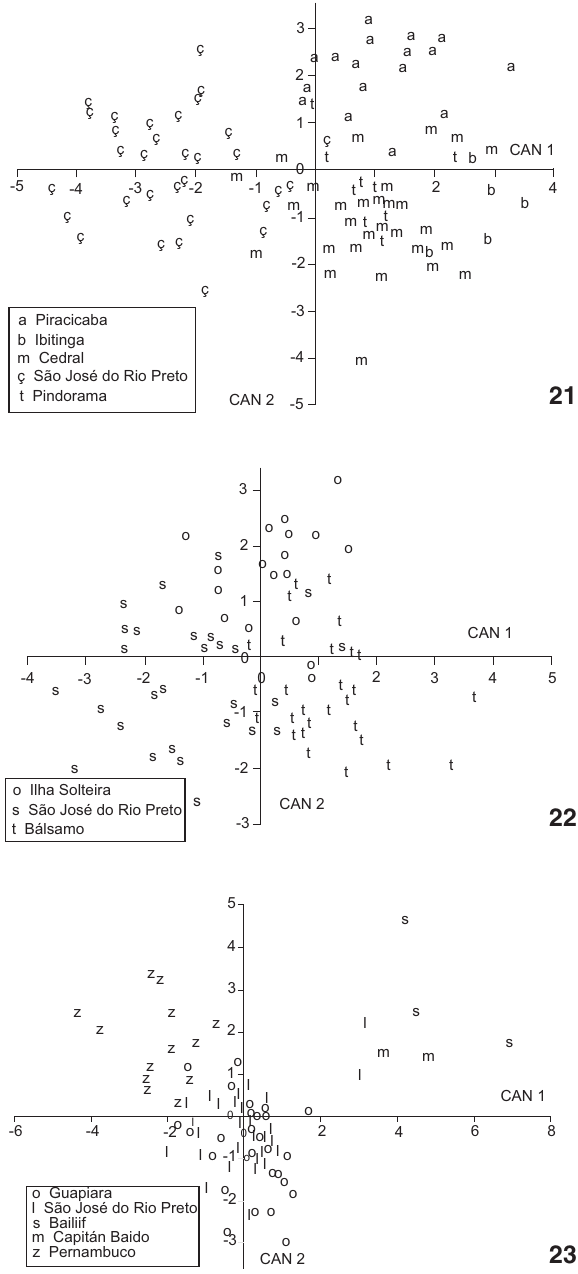
Figuras 21-23. Distribuição morfométrica com 15 caracteres, com- primento e largura do idiossoma e comprimento das setas dorsais, de fêmeas de E. banksi para todas as localidades de cada hospe- deiro analisada isoladamente. Localidades das coletas nas legen- das das figuras. (21) 91 fêmeas oriundas de H. brasiliensis de loca- lidades próximas; (22) 79 fêmeas oriundas de P. aquatica também de localidades próximas; (23) 78 fêmeas oriundas de Citrus sp. no Brasil Guadalupe e Paraguai.